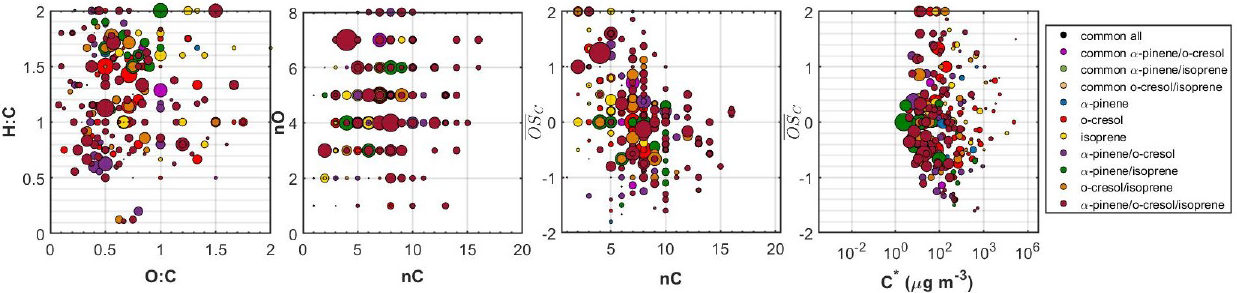
Figure 5. Hydrogen to carbon (H : C) by oxygen to carbon (O : C), number of carbon atoms (nC) by number of oxygen atoms (nO), carbon oxidation state (OSc) by nC, and OSc by effective saturation concentration ( C ∗ ) of all the individual products identified in the ternary system. The dots are sized based on the square root of their particle-phase signal in the FIGAERO-CIMS. The products that were common between all systems, those that were common between α -pinene, o -cresol, and their mixture, those that were associated with either precursor, those that were unique products of each binary system, as well as those that were unique products of the ternary mixture are depicted with separate